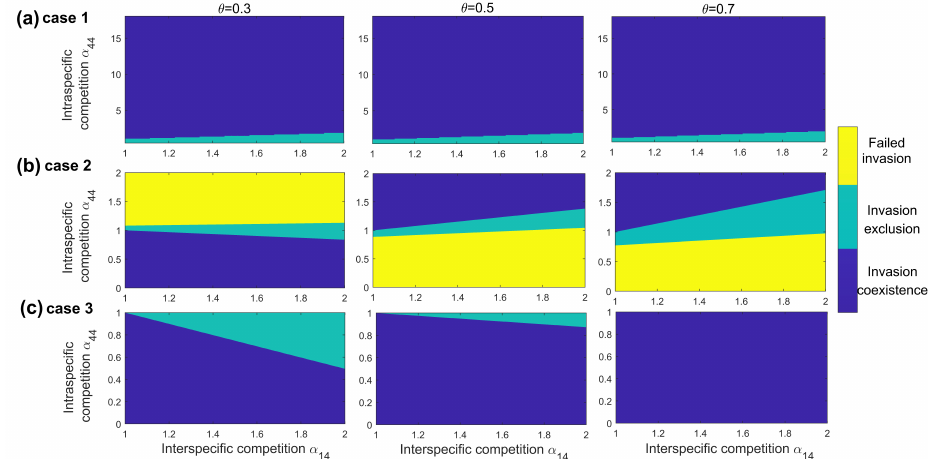
Figure 3. Parameter ranges for different invasive consequences (assuming alien species can only com- pete with species 1). Different figure rows correspond to three different native communities, which supported by ( a ) strong niche departure (case 1), ( b ) the combination of niche differentiation and intransitive competition (case 2), and ( c ) intransitive competition (case 3). Each columns exhibit three levels of competitive symmetry 1 − θ = 0.7, 0.5, 0.3. X axis represents the interspecific competition intensity between alien species and native species 1, α 14 . Y axis is intraspecific competition intensity of alien species α 44 . The parameter space is divided into several parts. Blue color area represents successful establishment of invader. Green color region suggests the conditions when alien species pose destructive effect and cause native extinctions; yellow color area identify the invasion failure. r 1 = r 2 = r 3 =